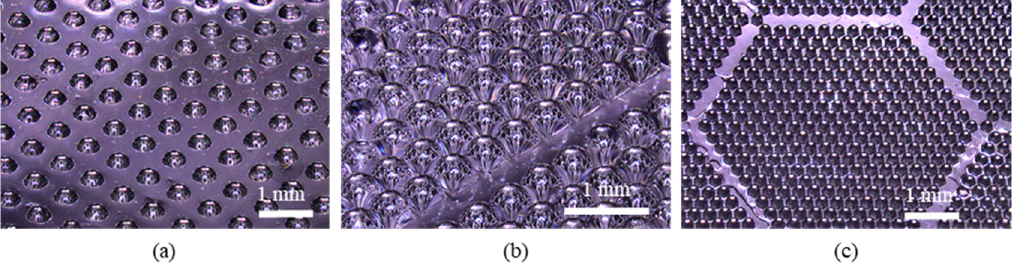
Figure 7. Overview of MLAs with: ( a ) circular aperture; ( b ) square aperture; ( c ) hexagonal aperture.